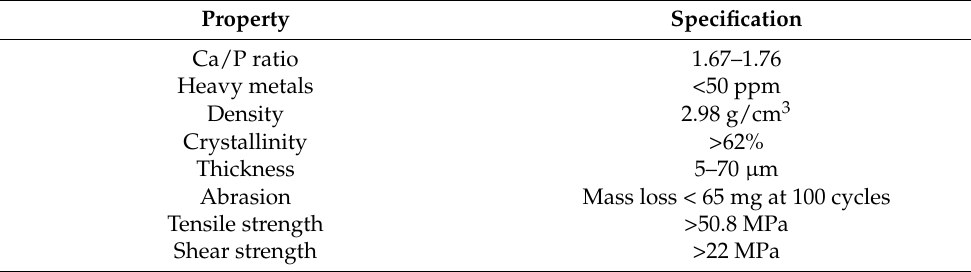
Table 2. Requirements for HAp coatings for biomedical application